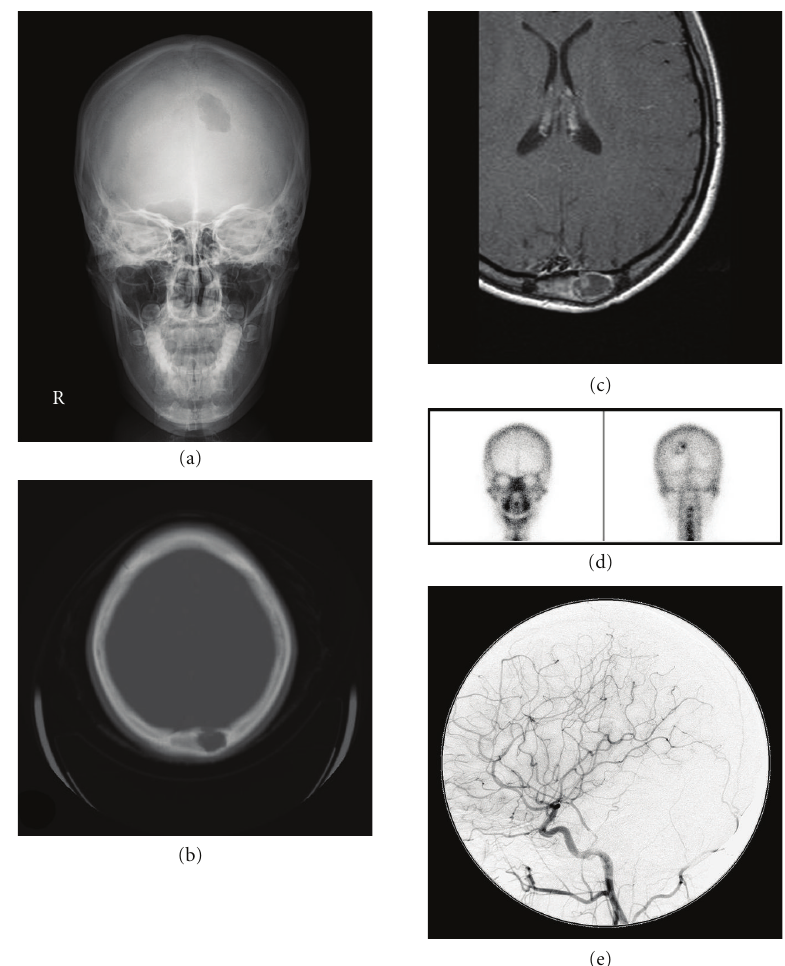
Figure 1: AP view of skull xp (a) showing the bony defect of the left occipital lesion. Bone image CT at the level of the subcutaneous mass (b) demonstrating the bony defect of the left occipital bone without a change in the intraaxial lesion. The skull surface of the de- fective part was swollen. Axial T1-weighted MRI with contrast medium (c) showing a cystic change corresponding to the bony defect and partial enhancement around the cystic change. 99m Tc-HMDP bone scintigraphy (d) showing accumulation of tracer in the part of the bone cyst corresponding to the strongly enhanced lesion found on MRI. Head DSA study (e, lateral view) demonstrating no abnormal vessels, including tumor feeder or aneurysmal